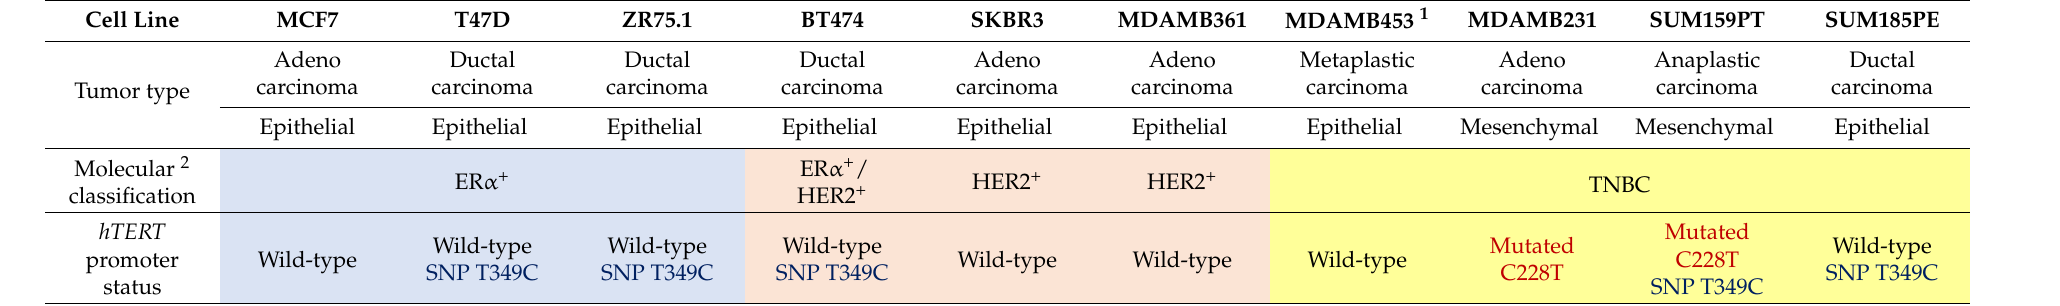
Table 1. Breast cancer cell lines used in the study. 1 Conflicting reports with ATCC indicating TNBC and some publications indicating HER2 amplified, although not highly expressed [46]. 2 Molecular classification: ER α + (estrogen receptor alpha expressing), HER2 + (HER2 amplified), TNBC (triple-negative, lacking ER, PR, and